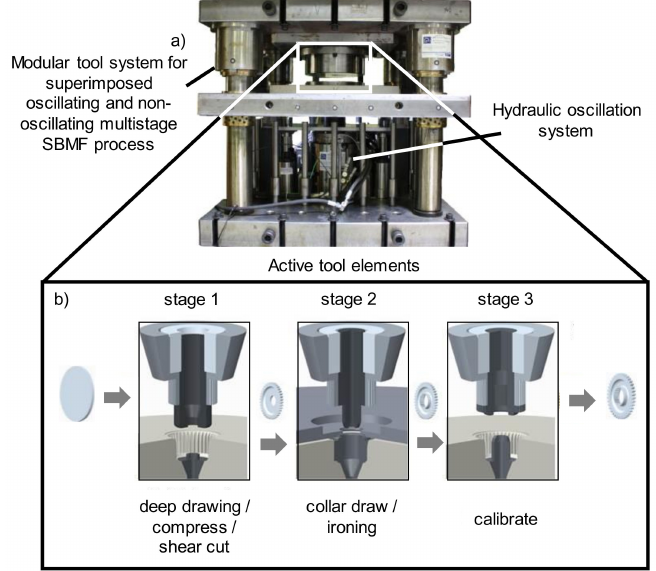
Figure 1. ( a ) Modular tool system for new multistage SBMF process, ( b ) Active tool elements of single stages of the SBMF process